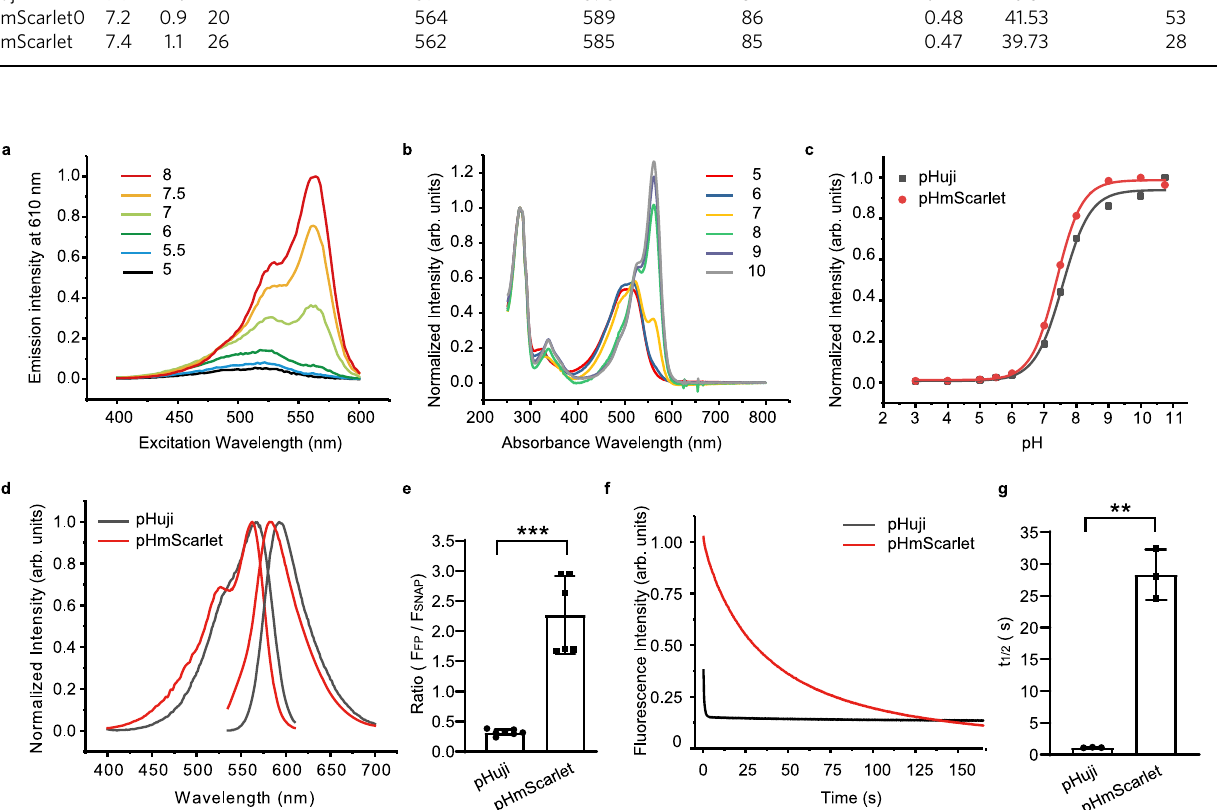
Fig. 1 Characteristics of pHmScarlet. a Excitation spectra and b Absorbance spectra of pHmScarlet at different pH values. c pH titration curves of pHmScarlet (red) and pHuji (black). d Excitation and emission spectra of pHmScarlet (red) and pHuji (black) at pH 7.4. e SNAP-normalized fl uorescence of FPs in U-2 OS cells expressing H2B-pHmScarlet or H2B-pHuji (pHuji: 0.32 ± 0.05, pHmScarlet: 2.27 ± 0.64, p = 0.0007, two-sided Student ’ s t tests. Data are presented as mean ± SD). f Photobleaching curves of pHmScarlet (red) and pHuji (black). g t 1/2 of pHmScarlet and pHuji (pHuji: 1.1 ± 0.1, pHmScarlet: 28.3 ± 2.5, p = 0.007, two-sided Student ’ s t tests. Data are presented as mean ± SD). Results shown are from three independent experiments. ** p <0.01, *** p <0.001. Source data is provided as a source data fi